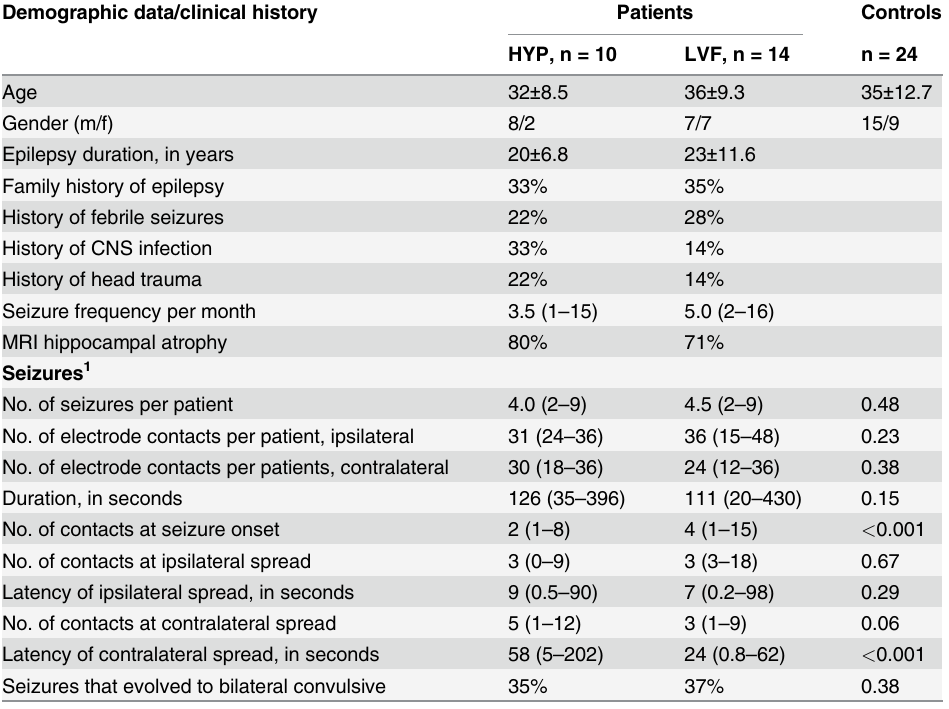
Table 1. Clinical and seizure statistics.